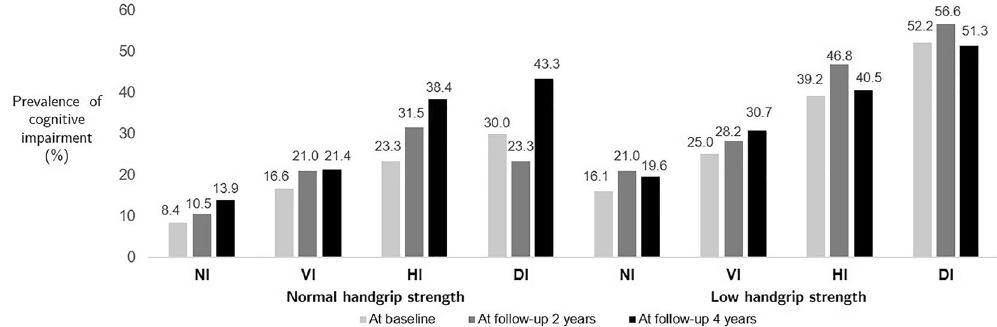
Figure 1. Prevalence of cognitive impairment stratified by handgrip strength status and type of sensory impairment by follow-up period. DI dual sensory impairment, HI hearing impairment only, NI no sensory impairment, VI vision impairment only.